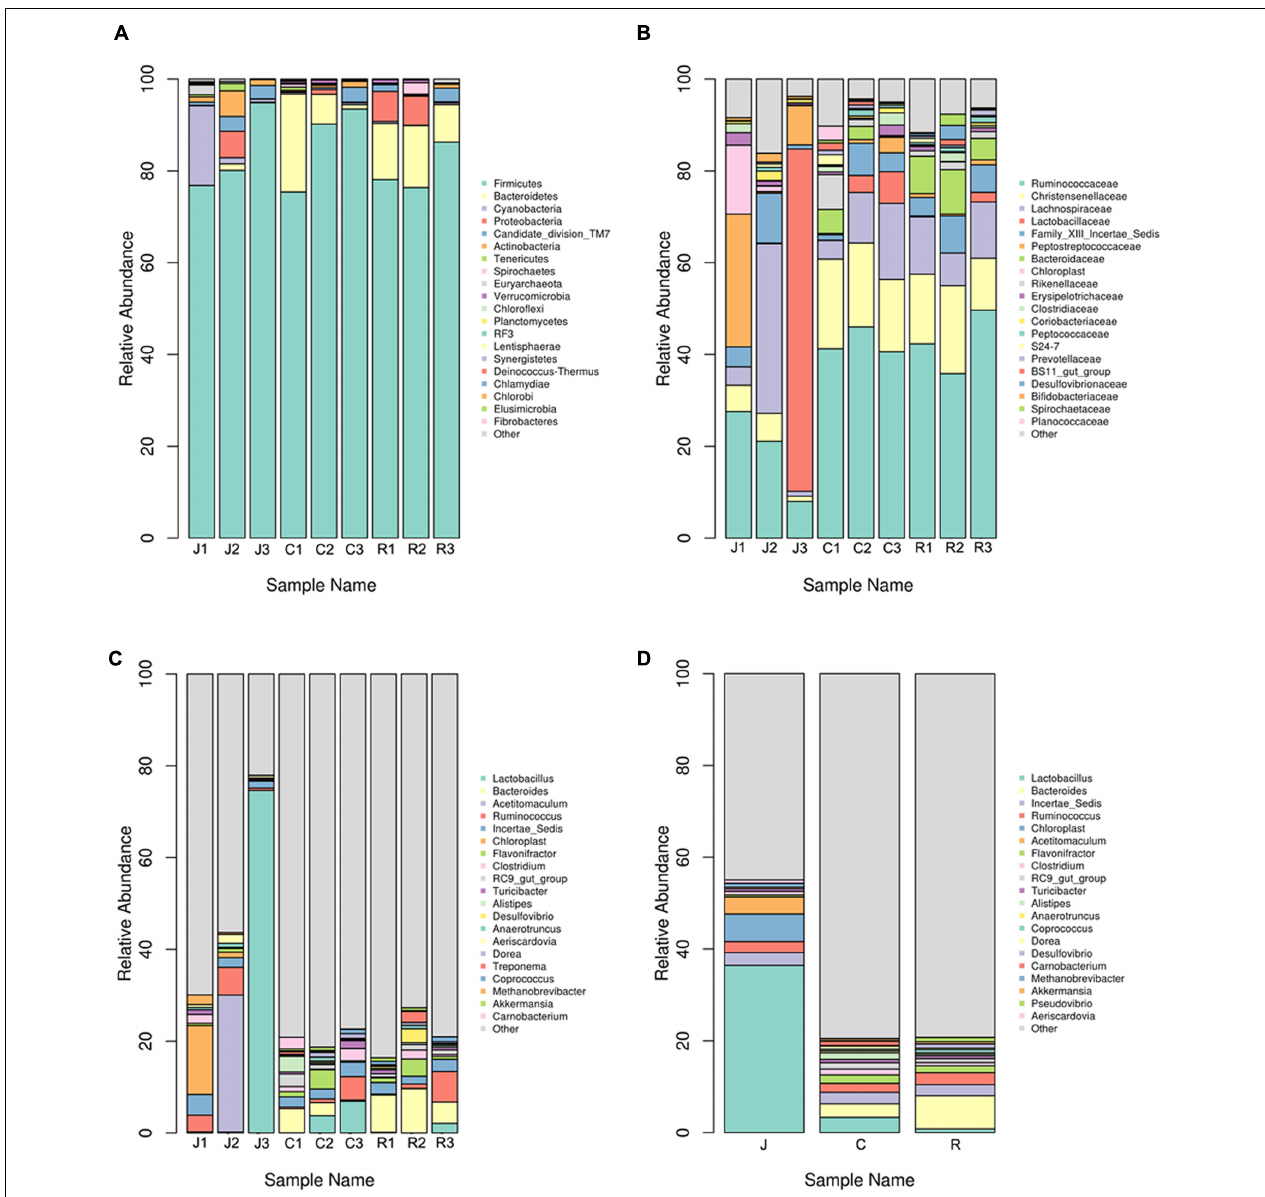
FIGURE 2 | Microbial composition of different samples. Each bar represents the average relative abundance of each bacterial taxon within a group. The top 21 abundant taxa are shown. (A) Taxa assignments at Phylum level. (B) Taxa assignments at Family level. (C) Taxa assignments at Genus level. (D) Between-group taxa assignments at Genus